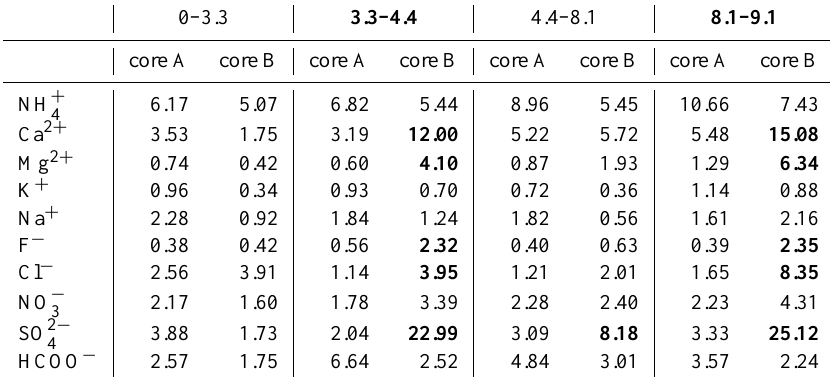
Table 1. Mean concentrations (µEqL − 1 ) for core A and B sections (depth in mweq). Bold values indicate major redeposition